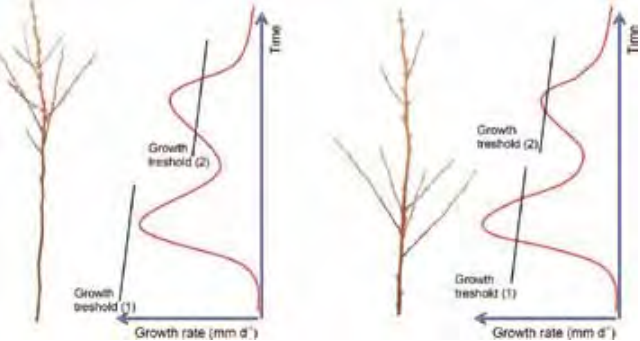
Fig. 1 - Shoot growth rate and sylleptic shoot formation in apricot. This model assumes that the growth rate threshold for inducing syl- leptic growth decreases during the season. Left: the threshold was overcome only at the end of the season. Right: the critical growth rate was overcome twice in the